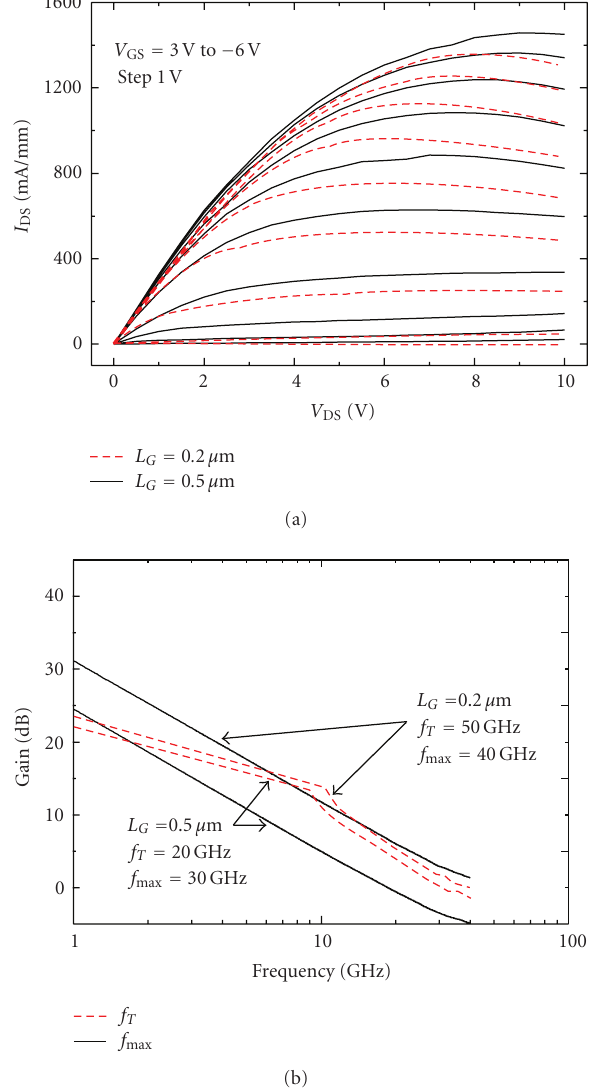
Figure 12: (a) I DS against V DS characteristics of fabricated two- finger 100 μ m gate width AlN/GaN MOS-HEMT with gate lengths of 0.2 μ m and 0.5 μ m, (b) the small-signal RF performances. The devices are biased at V GS = − 2 . 5V and V DS =